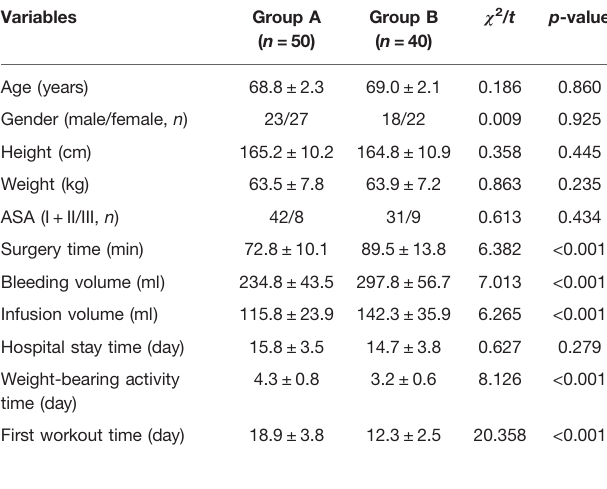
TABLE 1 | Comparison of demographic and perioperative data between the two